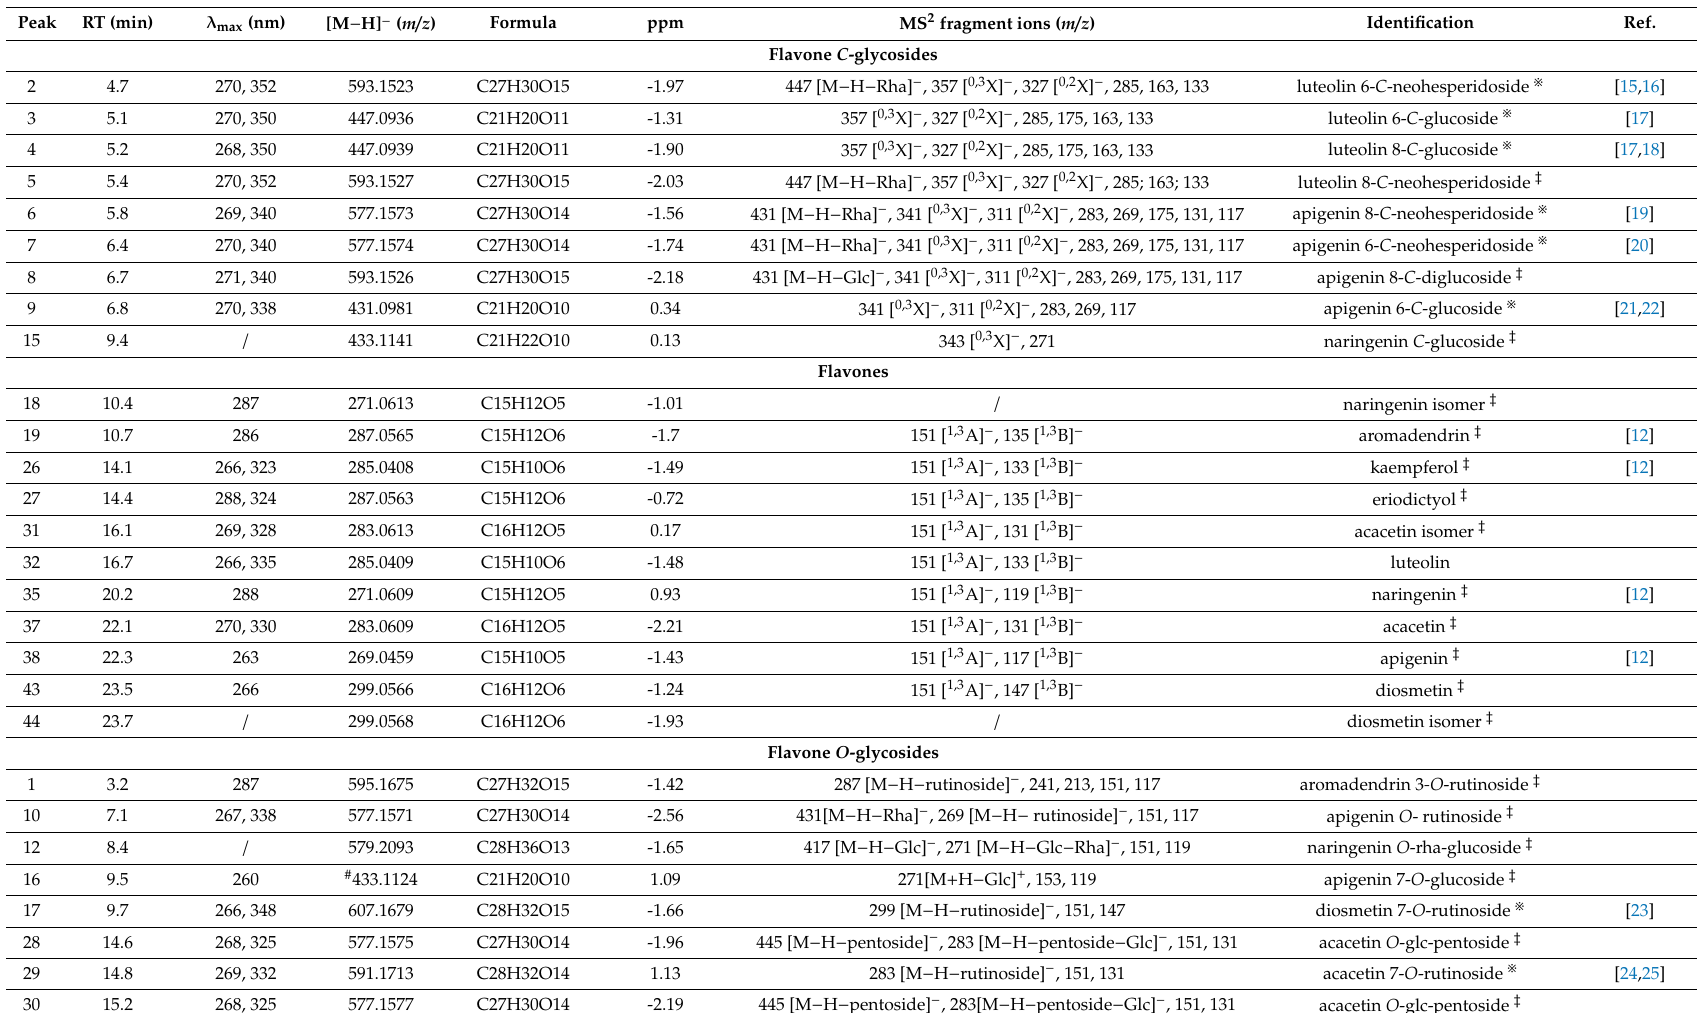
Table 1. Identification of 46 flavonoids from OHPLE by UPLC-ESI-QTOF-MS /